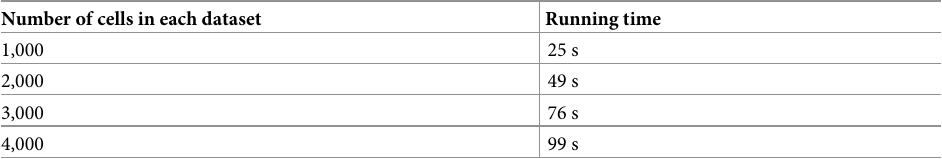
Table 1. Computational time of sc-UniFrac on two datasets composed of 25,507 genes. Number of cells in each